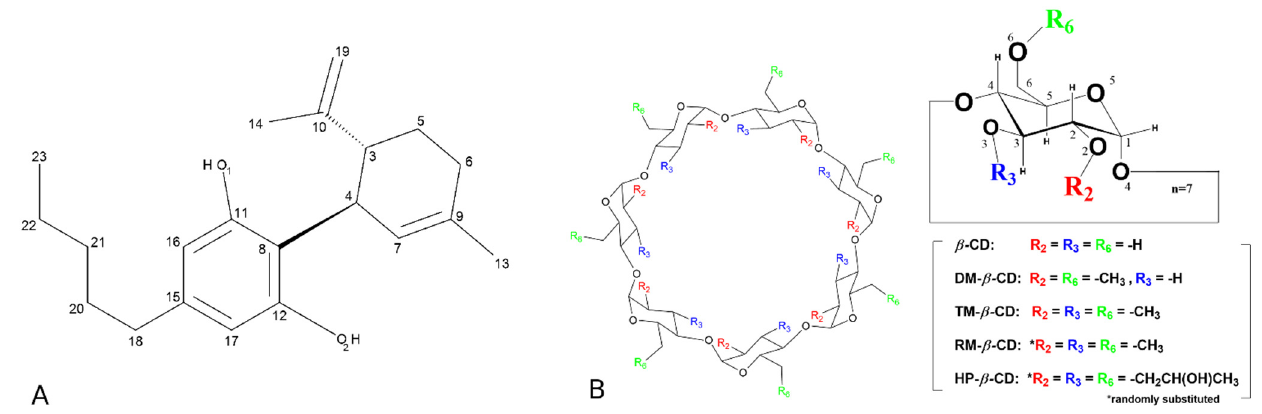
Figure 1. ( A ) Schematic representation of the chemical structure of cannabidiol (CBD) and ( B ) schematic representation of native β -cyclodextrin ( β - CD), heptakis(2,6-di- O -methyl)- β -cyclodextrin (DM- β - CD), heptakis(2,3,6-tri- O -methyl)- β -cyclodextrin (TM- β - CD), randomly-methylated- β -cyclodextrin (RM- β - CD), and 2-hydroxypropyl- β -cyclodextrin (HP- β - CD).